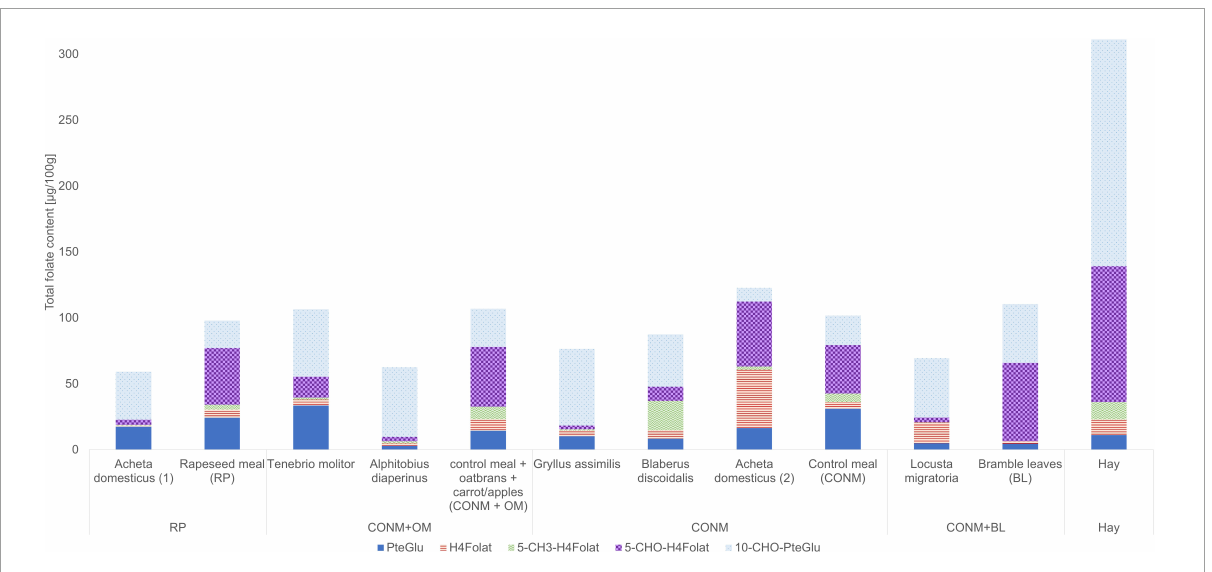
FIGURE2 Vitamer distribution of the folate content in the insects and the feed, calculated as PteGlu ( µ g/100 g of fresh weight).